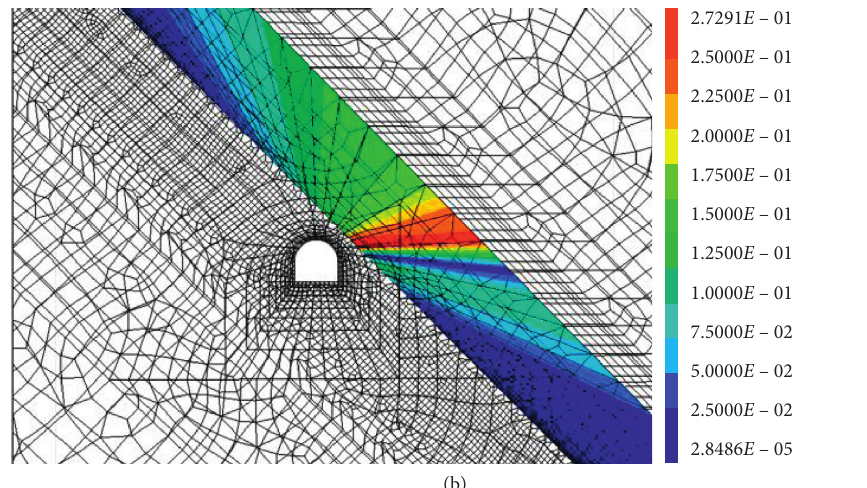
Figure 6: Nephogram of shear displacement on weak structural plane of roadway roof strata: (a) without support; (b) original